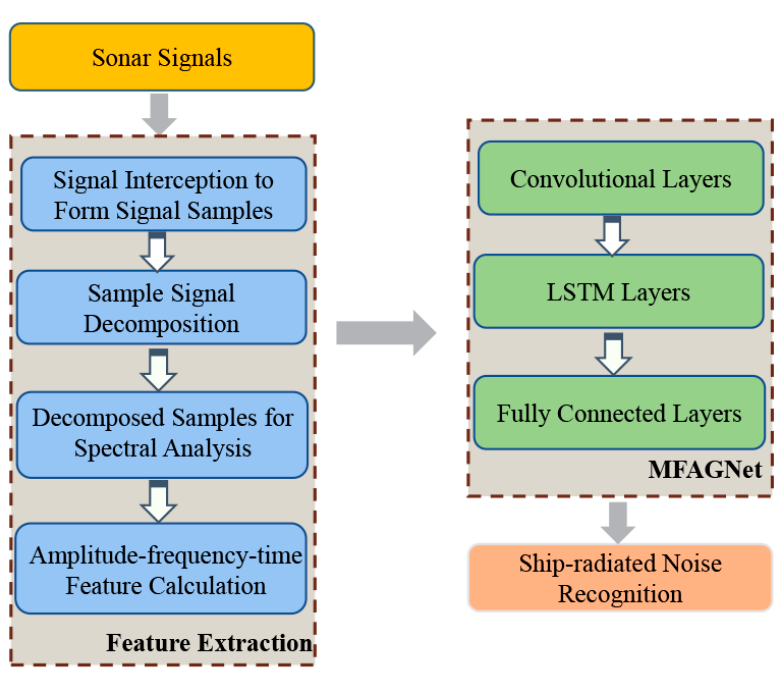
Figure 2. The flowchart of the proposed ship-radiated noise recognition system.